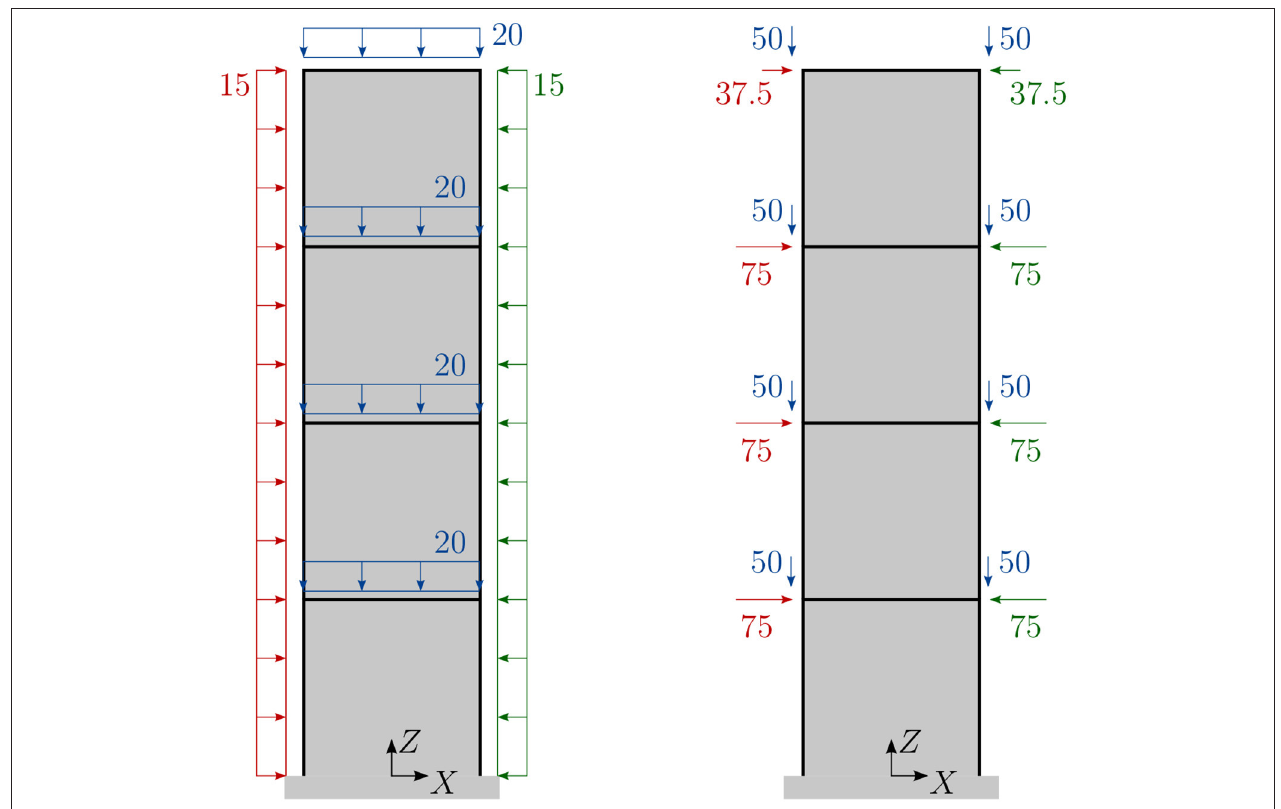
FIGURE 3 | Example 1, truss design: three investigated load cases (red, green, and blue), with line loads in kN/m and nodal forces in